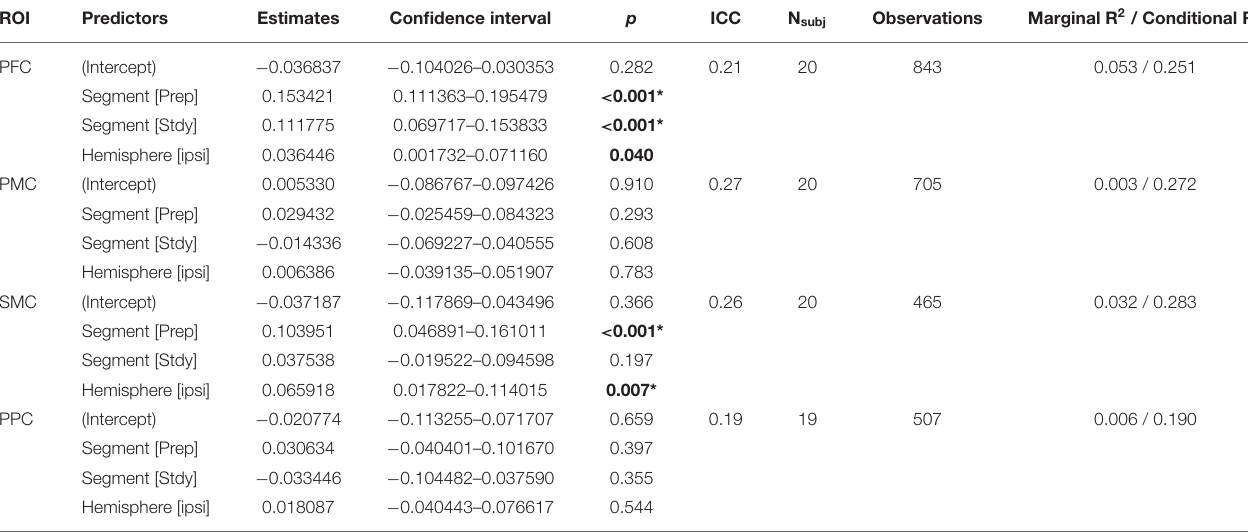
TABLE 2 | Linear mixed-effects models results for HbO: HbO ∼ Condition + Hemisphere +